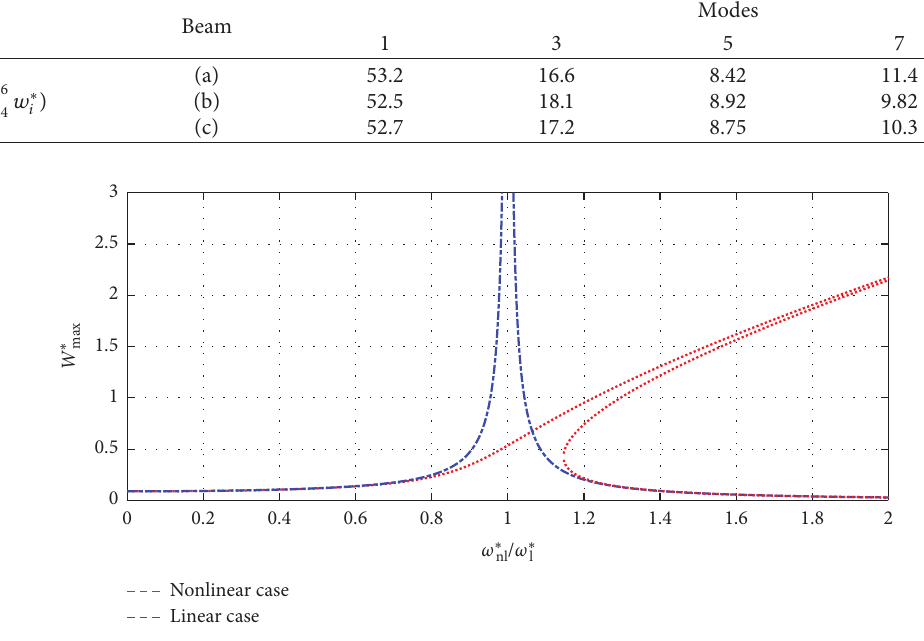
Figure 11: Linear and nonlinear frequency response functions’ comparison for beam